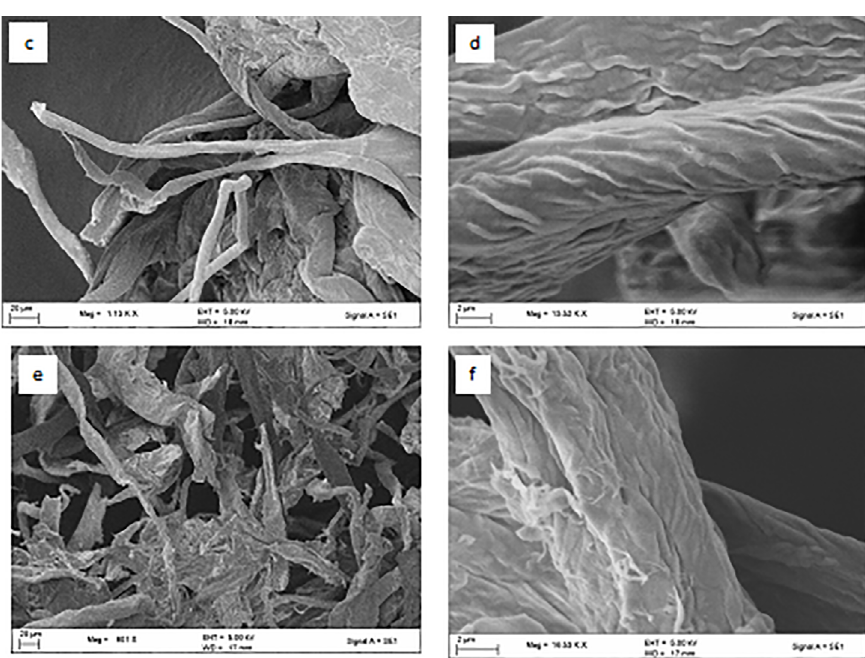
Figure 3. SEM micrographs of cellulose extracted from sugarcane bagasse through method 1 (c, d), method 2 (e,